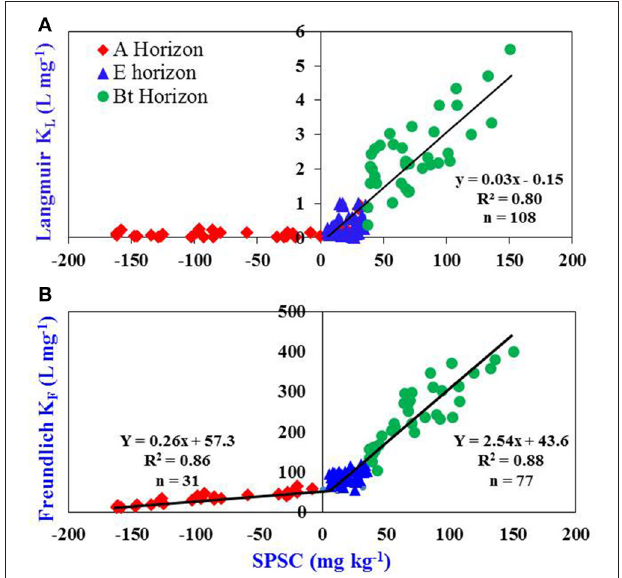
FIGURE 3 | Relationship between: (A) K L and soil P storage capacity (SPSC) and (B) K F and SPSC for A, E, and Bt horizons of Ultisols/Entisols/Alfisols. The relationship between K L and positive SPSC is linear; y = 0.03 x–0.15. The relationship between K F and SPSC has been divided into two parts: positive SPSC and negative SPSC. The relationship of K F under both the situations (positive and negative SPSC) is linear; y = 0.26 x + 57.3 and y = 2.54 x + 43.6, respectively. The units for each parameter in the linear equations are Y = L mg − 1 , X = mg kg − 1 , 0.03 = L mg − 1 , 0.15 = mg